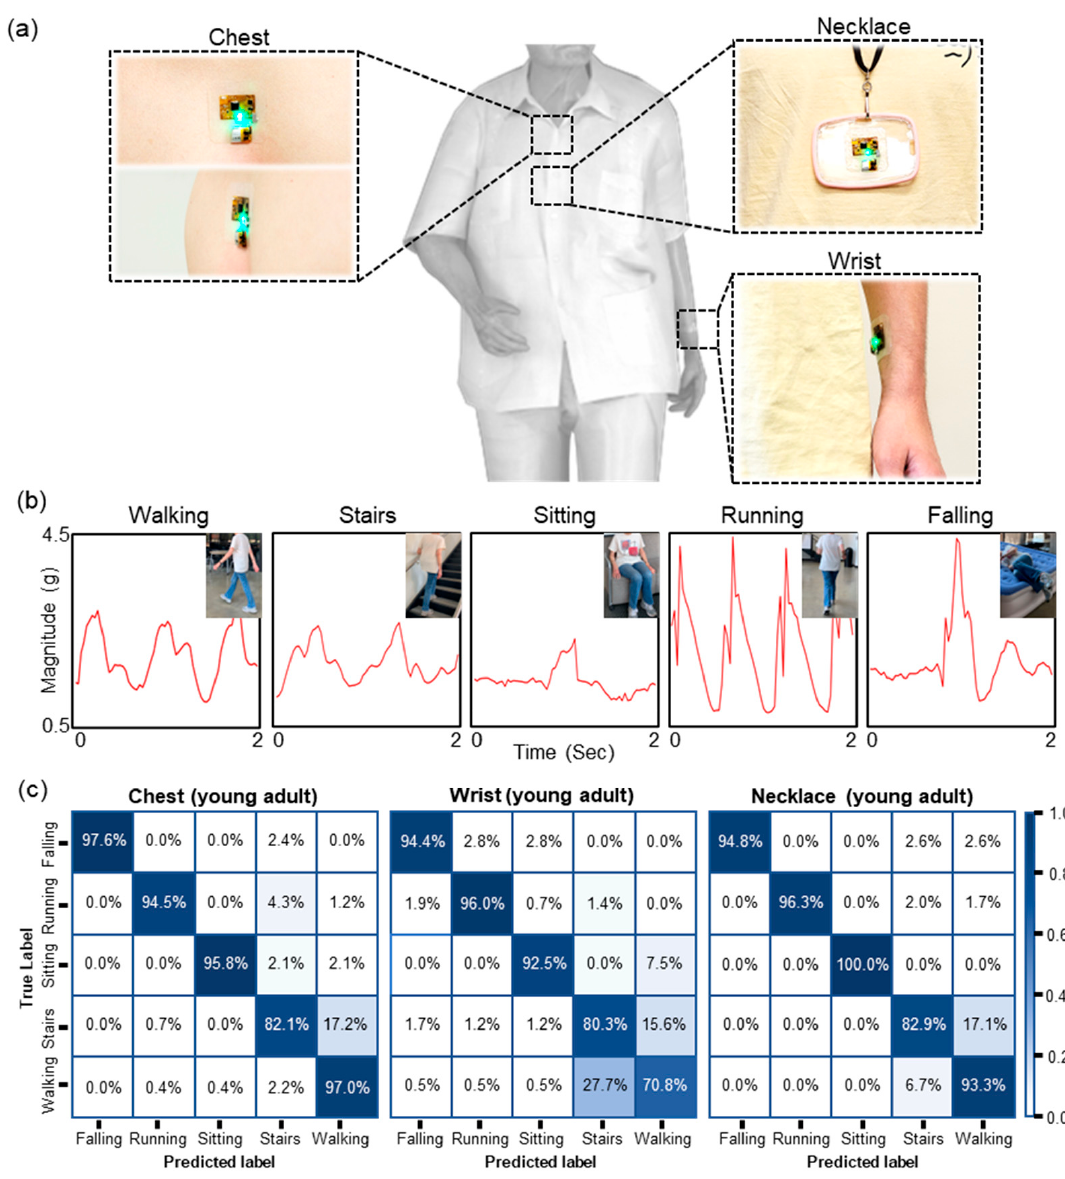
Figure 3. The optimal body location for the device placement. ( a ) Images of the SWM device placed on three different body locations: chest, wrist, and necklace. The device formed intimate integration on the skin without adhesives during the data collection. ( b ) Representative motion data in the form of the magnitude of the acceleration for each activity. ( c ) Confusion matrices obtained from the purposed LSTM model trained and tested using motion data collected from the chest, wrist, and necklace.